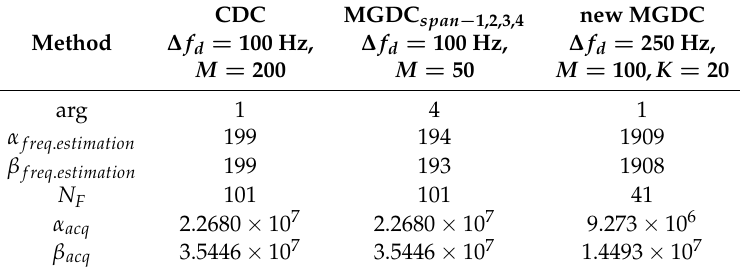
Table 2. Comparing the computation complexity in the same estimation